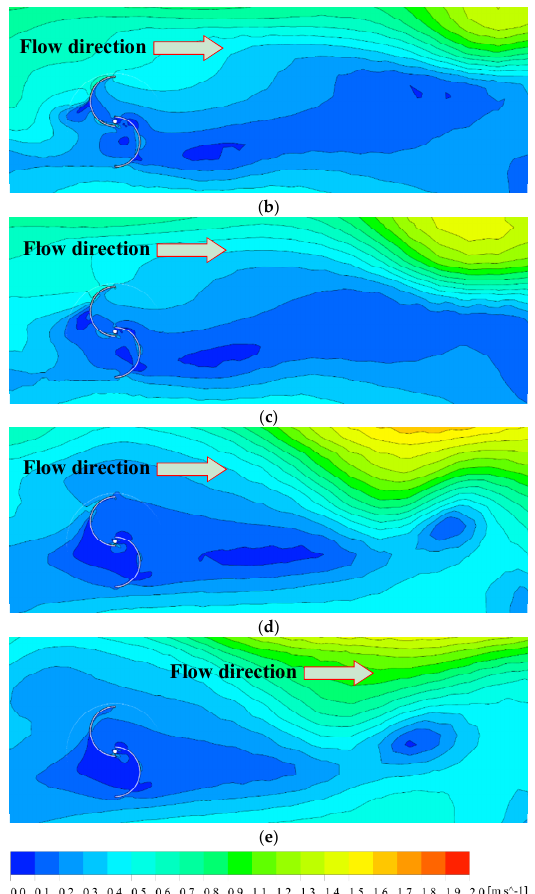
Figure 17. Time-dependent velocity distributions in wavy flows near a Savonius rotor. ( a ) T 0 ; ( b ) T 0 + 0.25 s; ( c ) T 0 + 0.5 s; ( d ) T 0 + 0.75 s; ( e ) T 0 + 1.0 s.